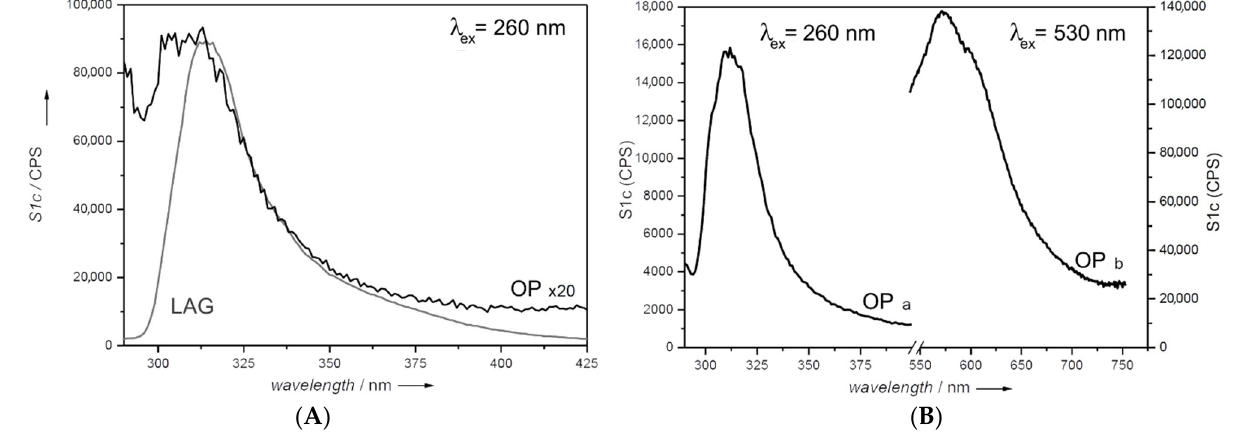
Figure 5. Fluorescence emission spectra. Left side ( A ), CTA_FL_SAP_OP (black curve) and CTA_FL_SAP_LAG (grey curve) recorded with an excitation λ of 260 nm (2.5 nm and 3 nm aperture slits and 2 s of integration time). The intensity of the black curve is multiplied 20 times. Right side ( B ), emission spectra of the CTA_FL_SAP_OP sample recorded with an excitation λ of 260 nm (curve a) and λ 530 nm (curve b) (both curves were recorded with 4 nm and 4 nm aperture slits and 2 s of integration time).